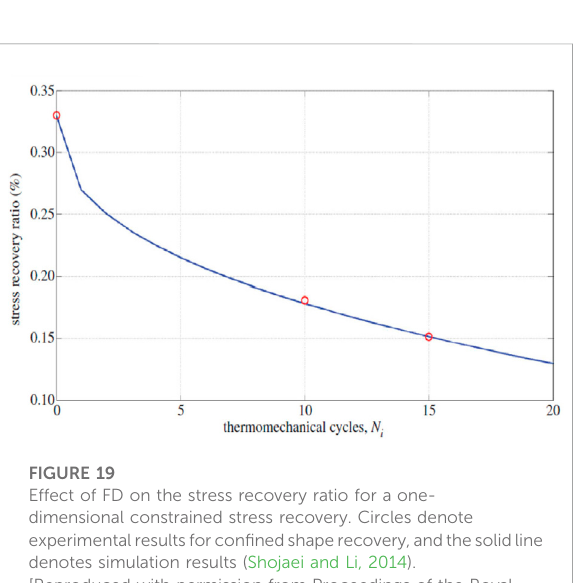
FIGURE 19 Effect of FD on the stress recovery ratio for a one- dimensional constrained stress recovery. Circles denote experimentalresultsforcon fi nedshaperecovery,andthesolidline denotes simulation results (Shojaei and Li, 2014). [Reproduced with permission from Proceedings of the